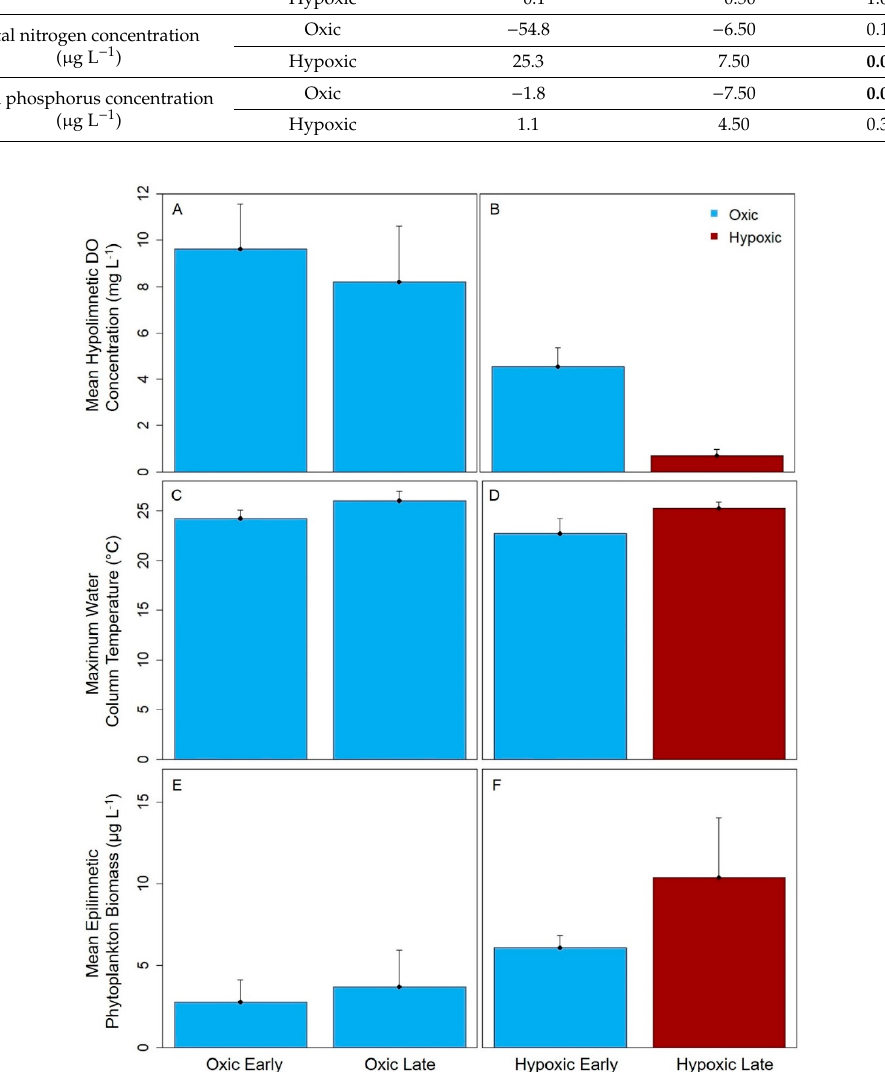
Figure 2. Changes in mean (error bar is 1 standard deviation (SD)) hypolimnetic dissolved oxygen concentrations ( A , B ), maximum water column temperatures ( C , D ), and mean epilimnetic phytoplankton biomass ( E , F ) between the seasonally oxic (left column) and the seasonally hypoxic (right column) reservoirs.